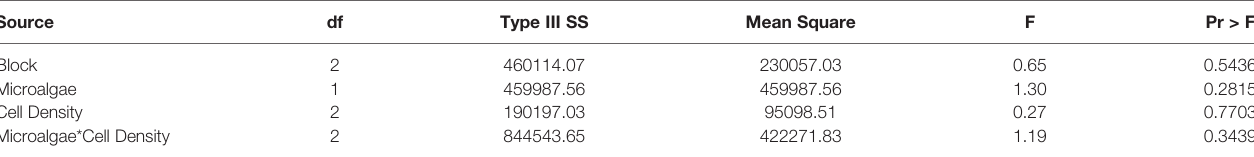
TABLE 3 | GLM (two-way ANOVA) table summarizing analysis of FR of the pleated tunicate Styela plicata by microalgae treatment and cell density of the brown tide- forming pelagophyte Aureoumbra lagunensis , and control species Tisochrysis lutea (Experiment 3). Source